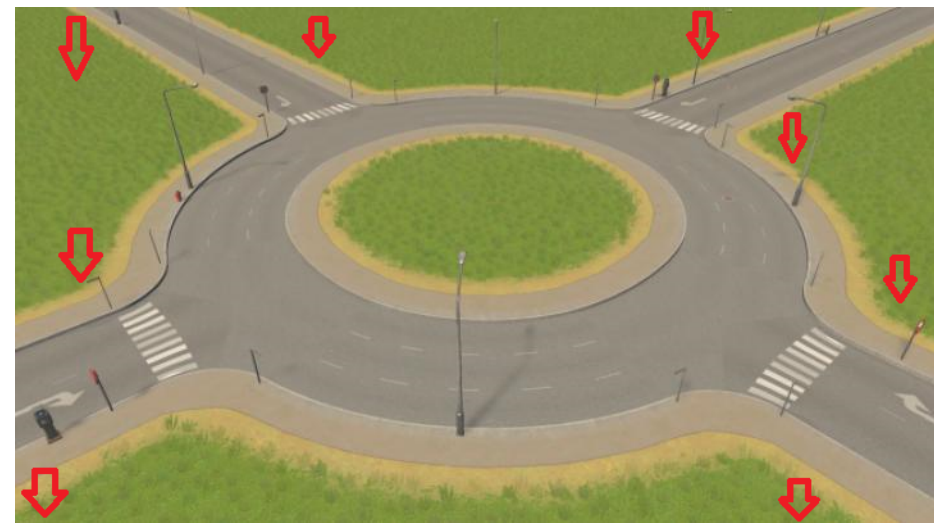
Figure 3. Sensors placement in the immediate vicinity of the